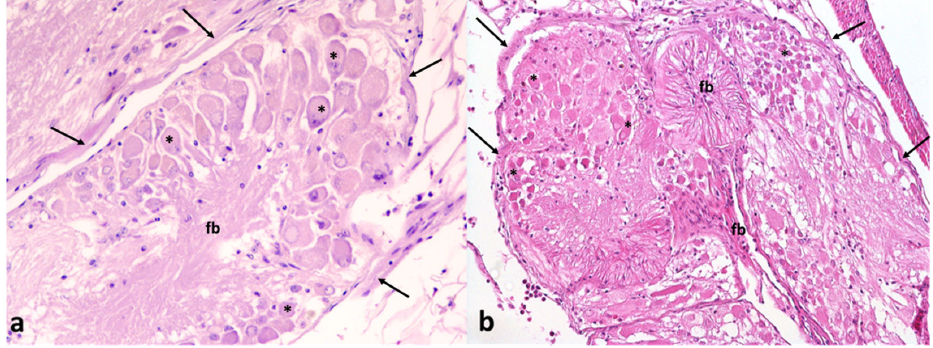
Figure 3. Nerve ganglia of T. mutabilis . Ganglia are lined by a rim of connective tissue (arrows) and are composed of pyrenophores (asterisks) and fiber bundles (fb). No signs of vacuolar degeneration or necrosis were present in ( a ) NNV ‐ negative and ( b ) NNV ‐ positive animals. Hematoxylin and eosin, magnification ×200 and ×100.